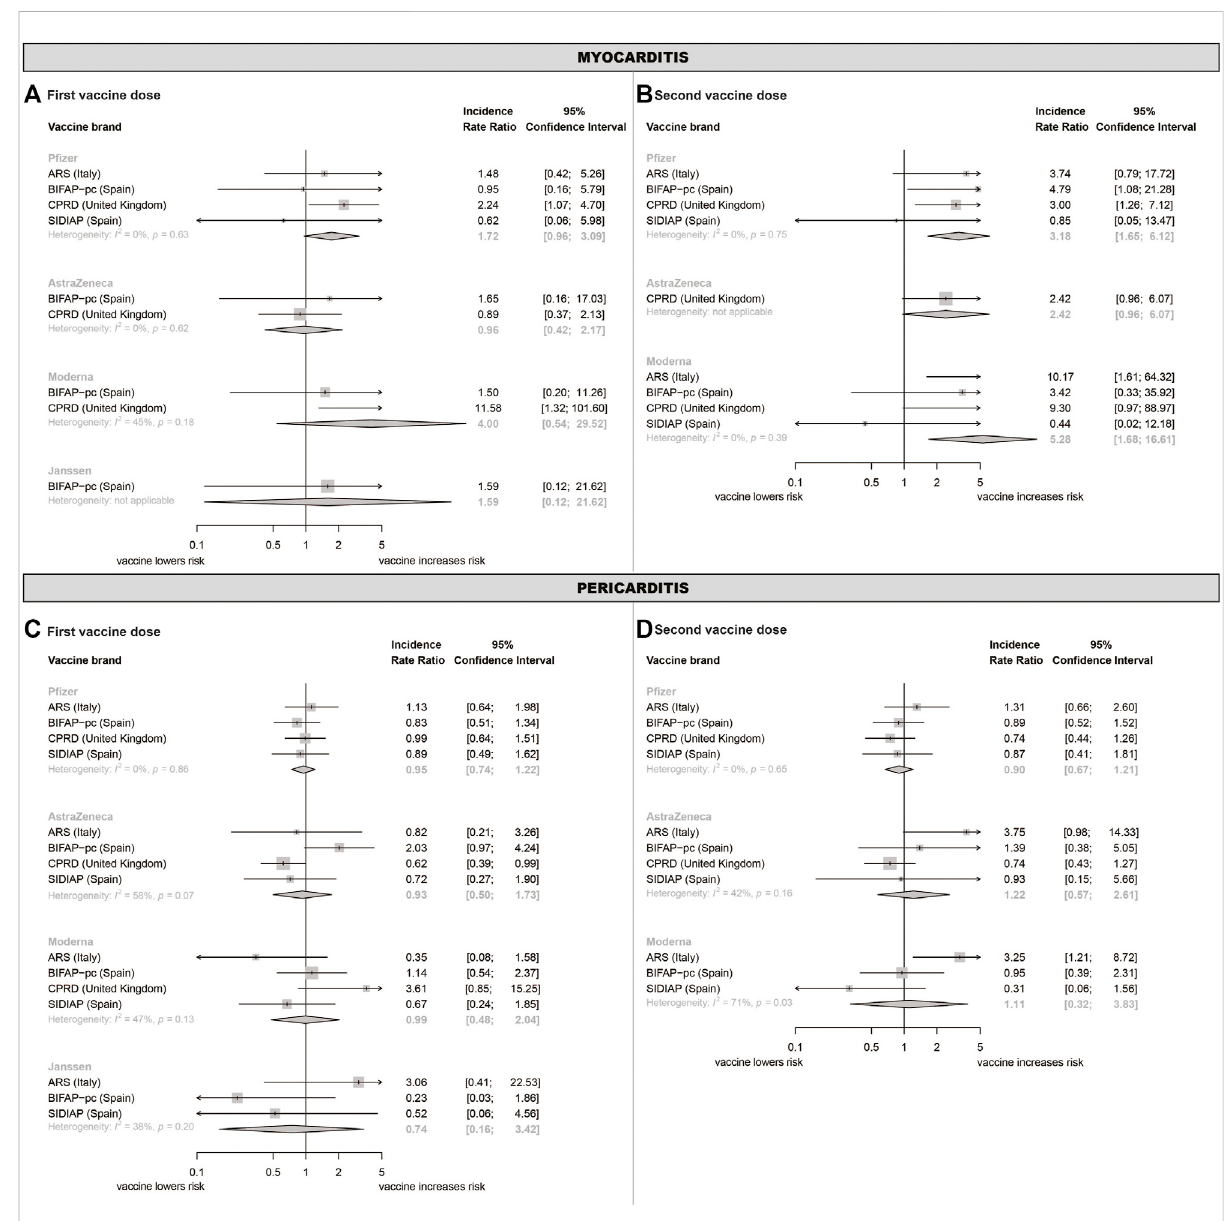
FIGURE 2 Meta-analysed incidence rate ratios of myo- and pericarditis following COVID-19 vaccination.